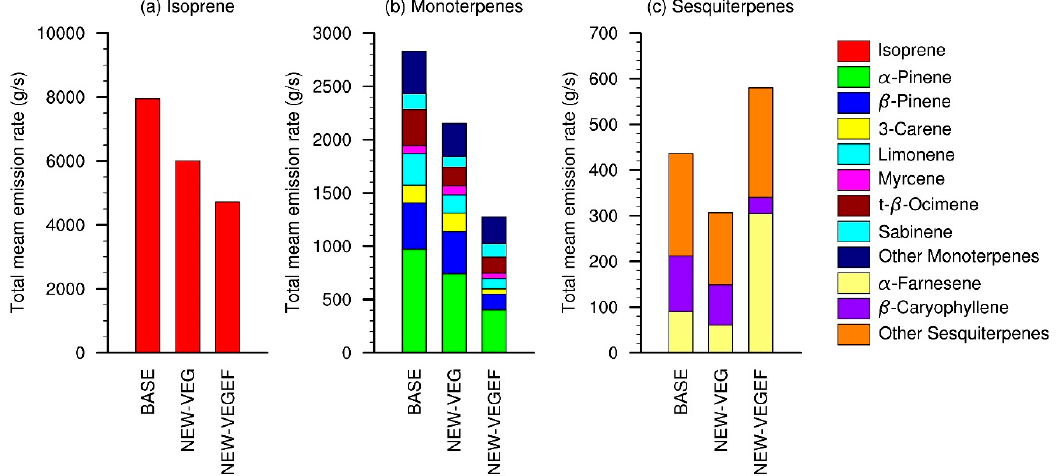
Figure 6. Total mean emission rates of ( a ) isoprene; ( b ) monoterpenes; and ( c ) sesquiterpenes estimated in the BASE, NEW-VEG, and NEW-VEGEF cases during the target period, aggregated in d04.